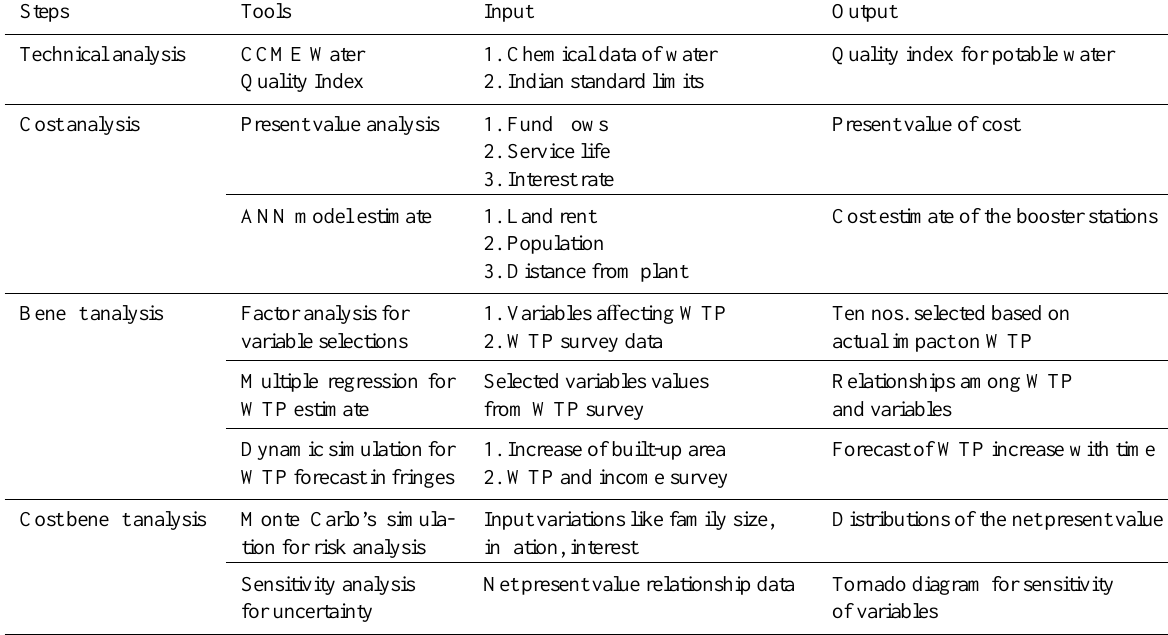
Table 1. Methodology